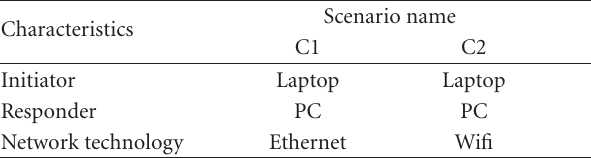
Table 3: Subscenarios C1 and C2 features.